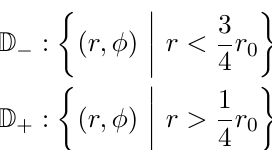
To (cid:12)nd the TCS decomposition of ~ M , we realize the disc as being glued from two open parts, see (cid:12)gure